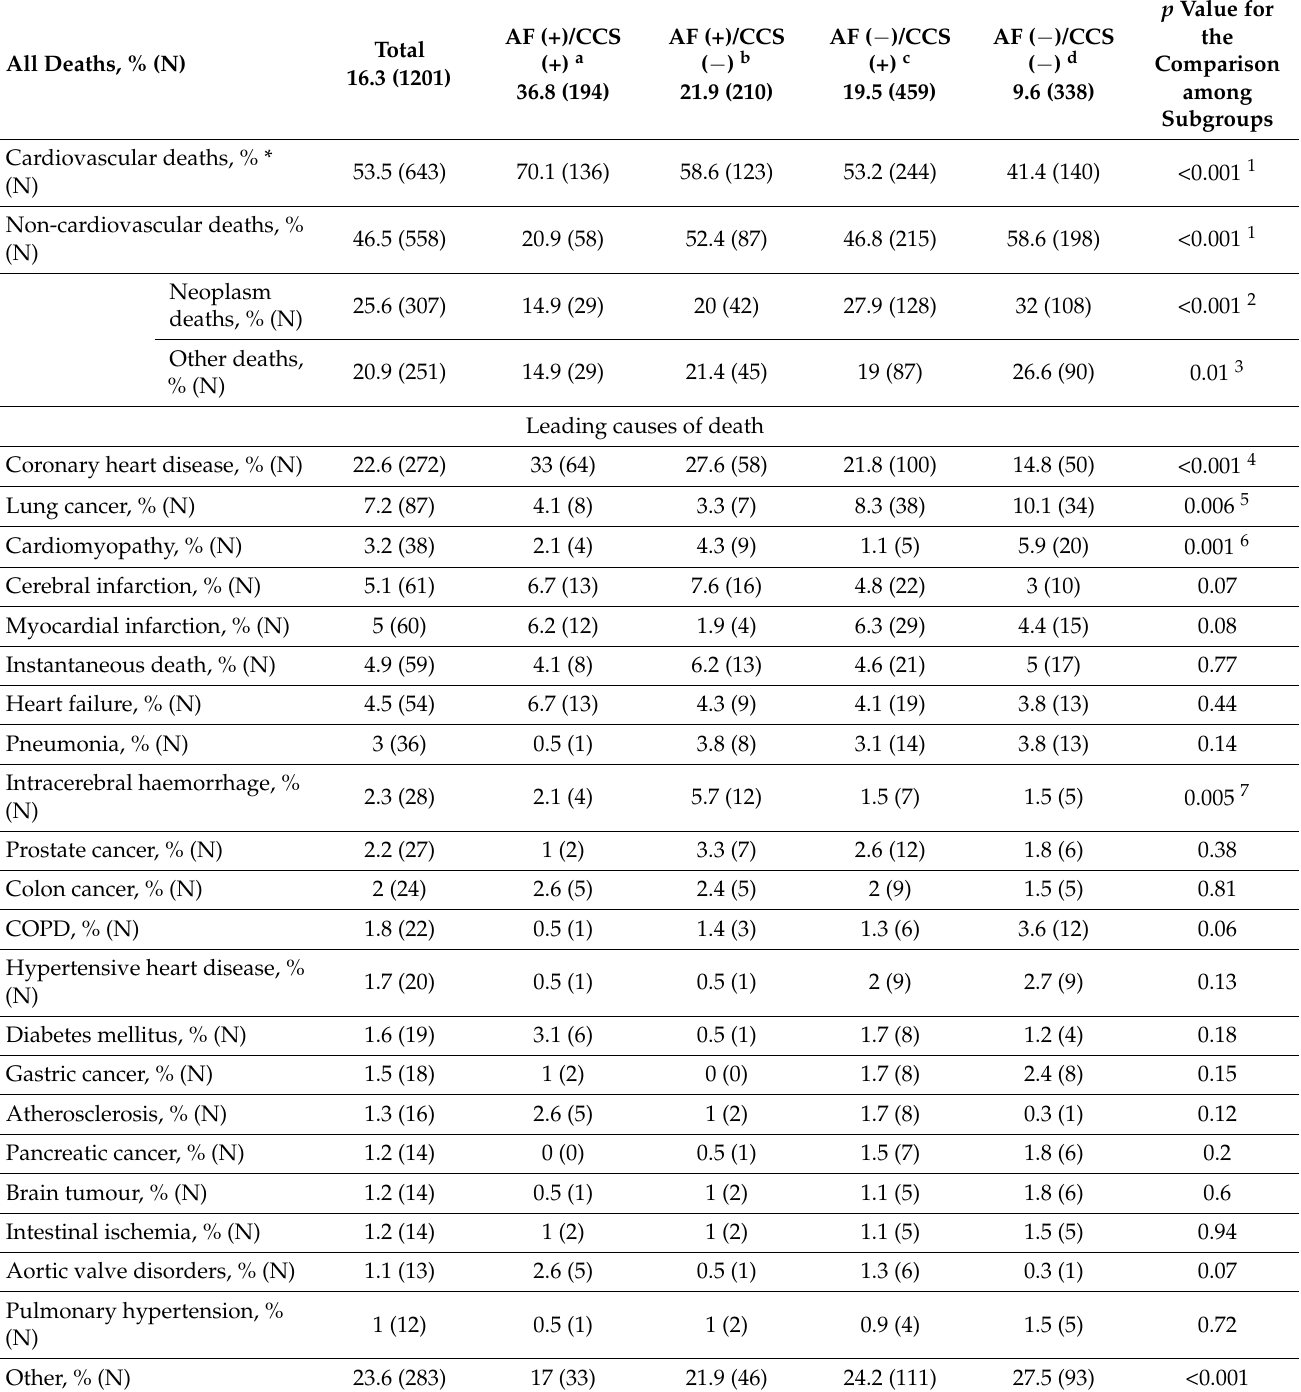
Table 3. Causes of deaths in the study